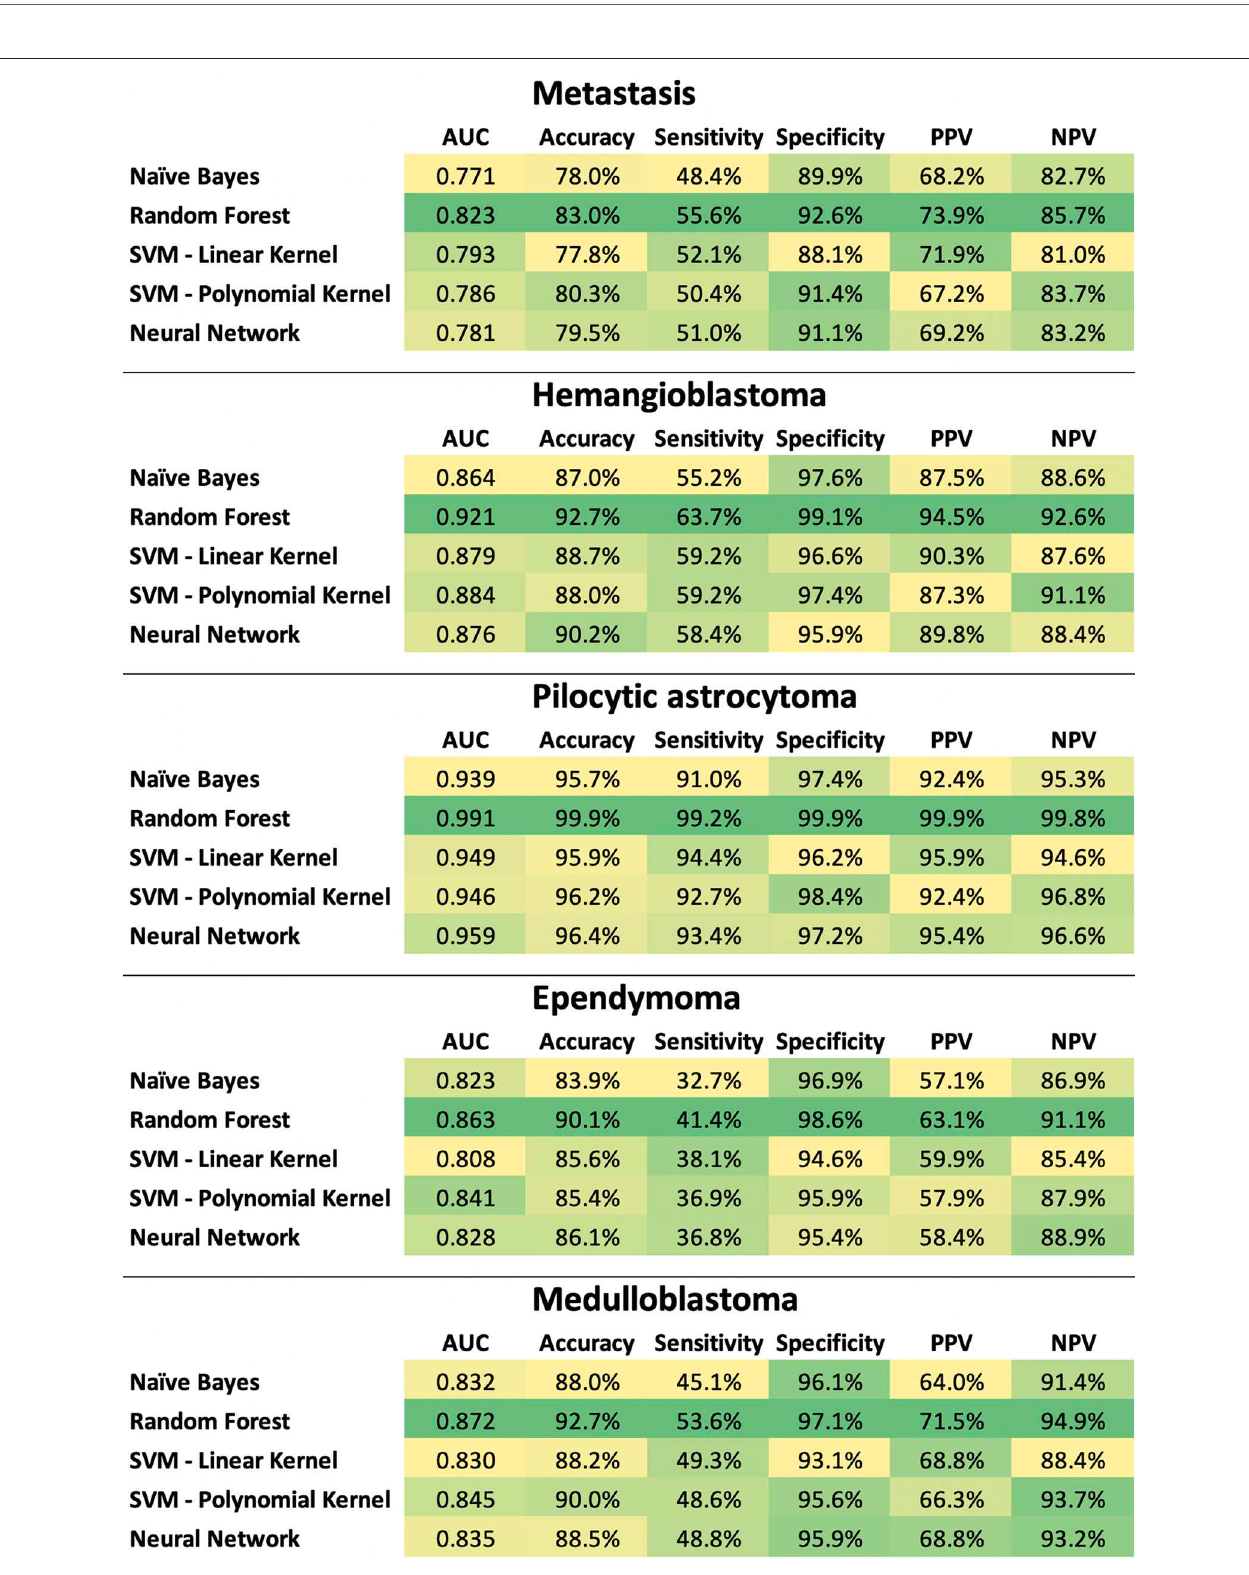
FIGURE 7 | Heat map summary for classification performance of different machine learning algorithms in dichotomized differentiation of the 5 most common posterior fossa tumors. The test characteristics were calculated in validation datasets from × 100 repeats of 5-fold cross validation– details in Supplemental Tables 2, 3 . NPV, negative predictive value; PPV, positive predictive value; SVM, support vector machine.